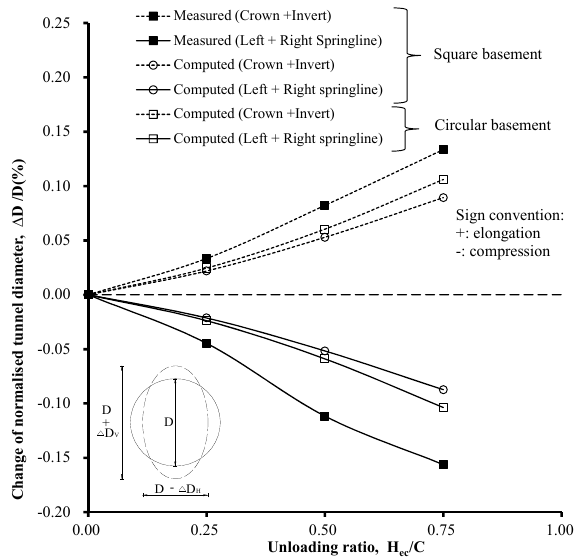
Figure 6. Comparison of tunnel diameter change.